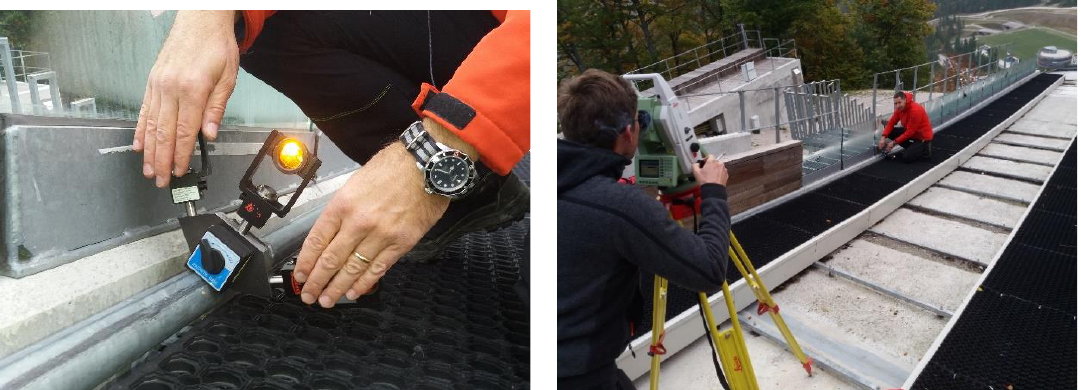
Figure 11. Measurements with the multi-prism method and the covering of two prisms during measurements on the inrun of Planica ski-flying hill.